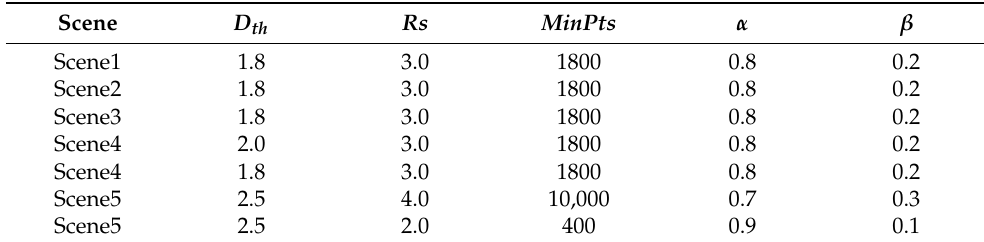
Table 1. Parameters of individual tree